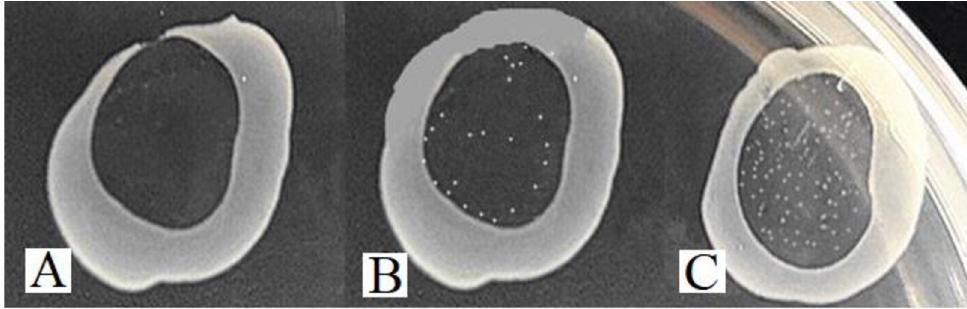
Fig 2. Characterization of L . monocytogenes phage sensitivity, drop assay using wild-type Lm3-22 and rliB deficient Lm3-22- Δ rliB . Phage vB-LmoM-SH3-3 was dropped on top of the deficient strain Lm3-22- Δ rliB (A), the wild-type strain Lm3-22 (B) and complemented strain Lm3-22- Δ rliB ::B (C). Phage vB-LmoM-SH3-3 formed clear and regular transparent spots on the upper layer of Lm3-22- Δ rliB , while bacteria clone growth still existed in the inhibition circle of Lm3-22 and Lm3-22- Δ rliB ::B, and the sensitivity of phage was stronger in Lm3-22- Δ rliB as compared with Lm3-22 and Lm3-22- Δ rliB :: B.